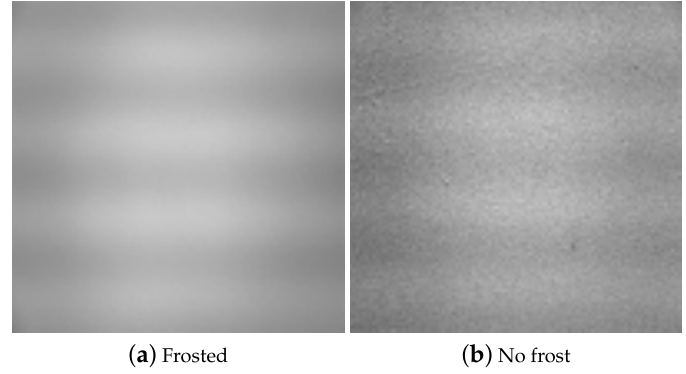
Figure 11. Frost and white/gray no-frost images are hard to